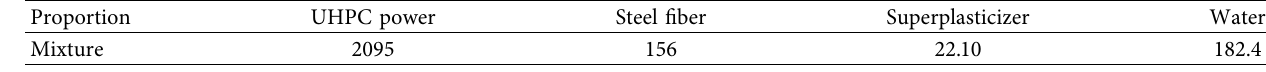
Table 2: Proportions of UHPC mixtures (unit: kg/m 3 ).